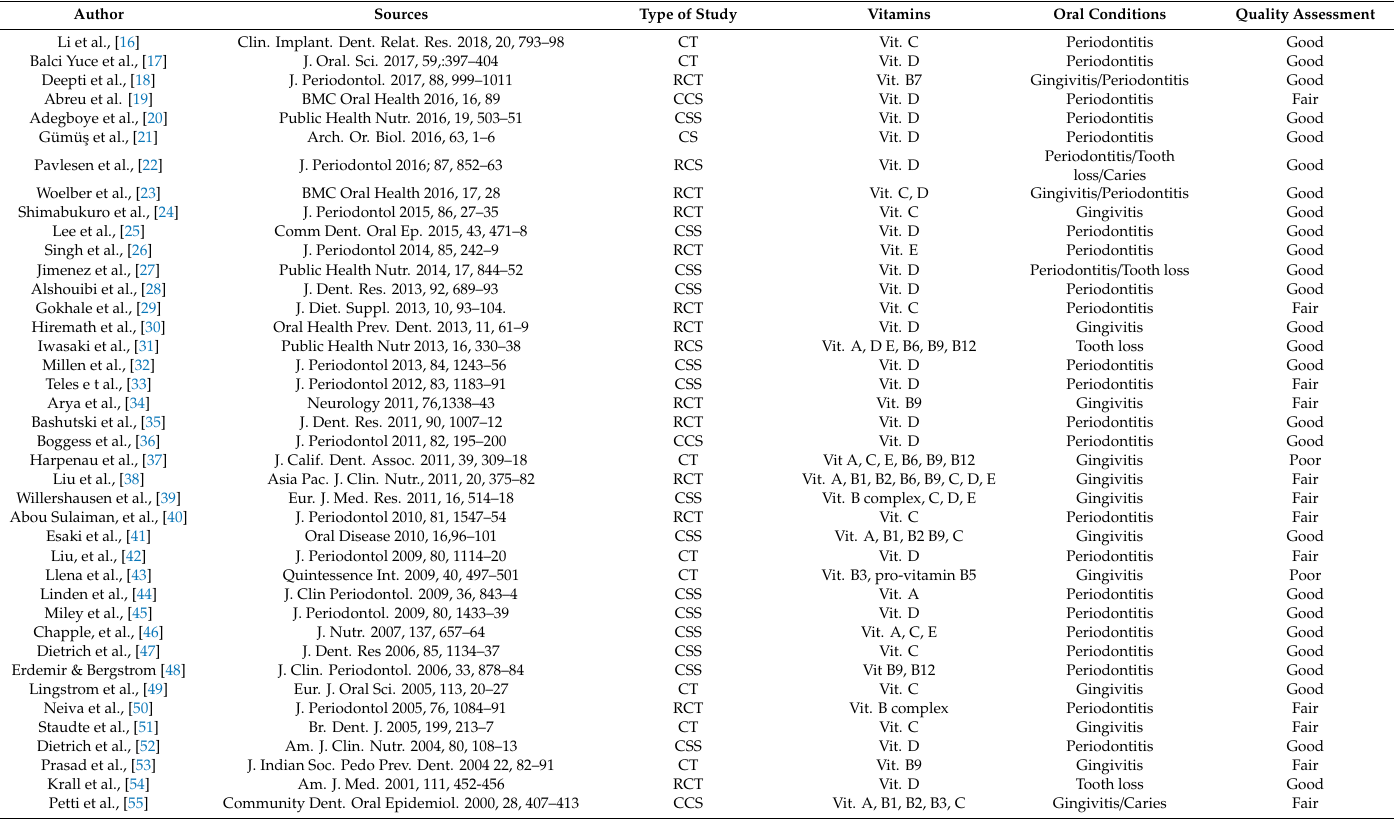
Table 1. General characteristics of the studies included: ( a ) Gingivitis and periodontitis; ( b ) Hard dental tissues (dental caries, enamel